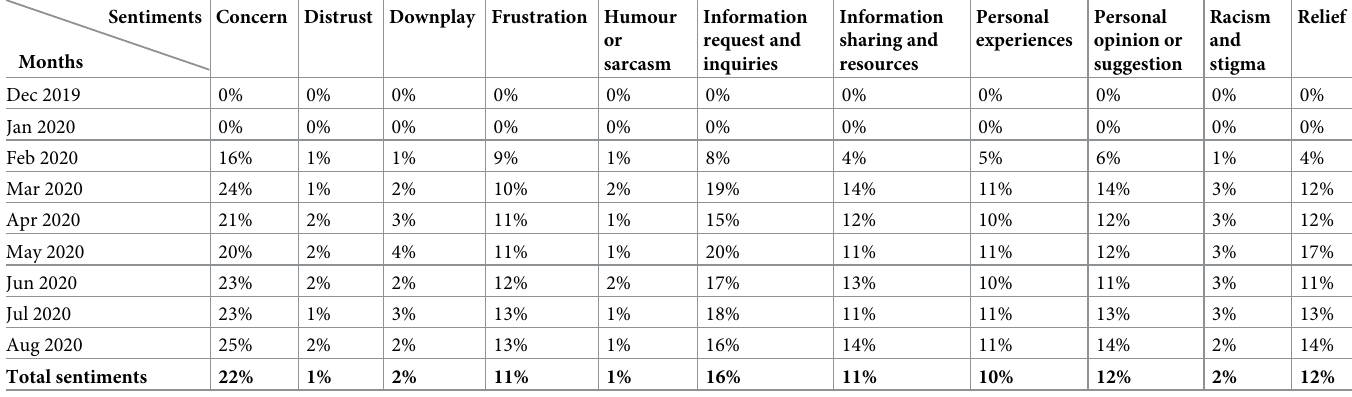
Table 4. The proportions of expressed sentiments per month towards the government and health officials’ accounts from December 31, 2019, to August 31, 2020. Sentiments Concern Distrust Downplay Frustration Humour or Months